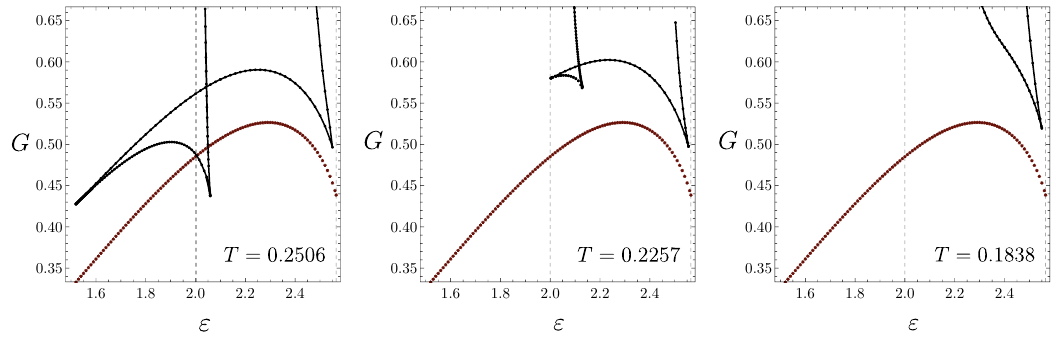
Figure 13 . Gibbs free energy against the boundary parameter for low temepreature black holes. It exhibits a swallowtail phase transition between the inelastic black hole phase and the soliton (brown